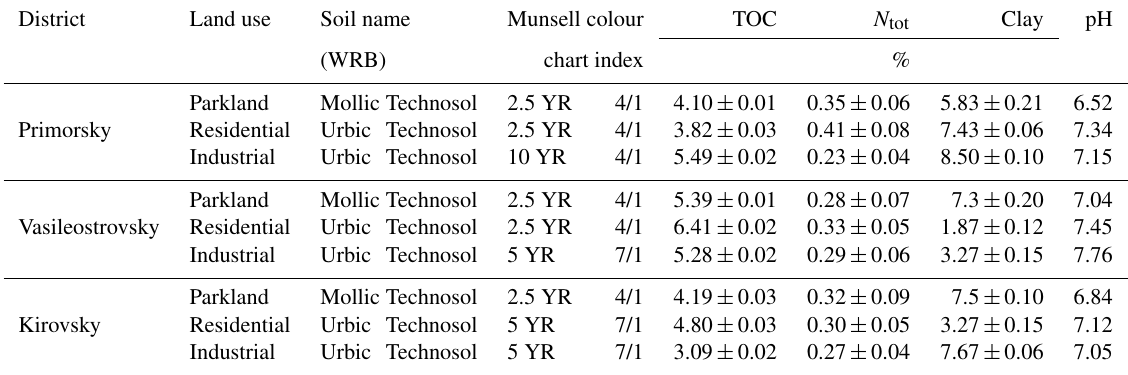
Table 2. Physicochemical properties of the studied soils. District